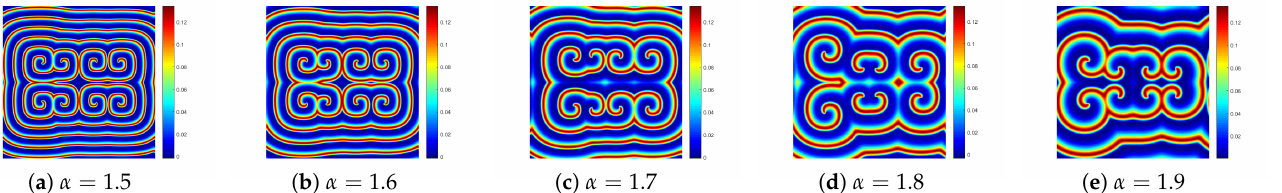
Figure 6. The stable spatio-temporal waves of v at t = 2000 and different α for Experiment 2.